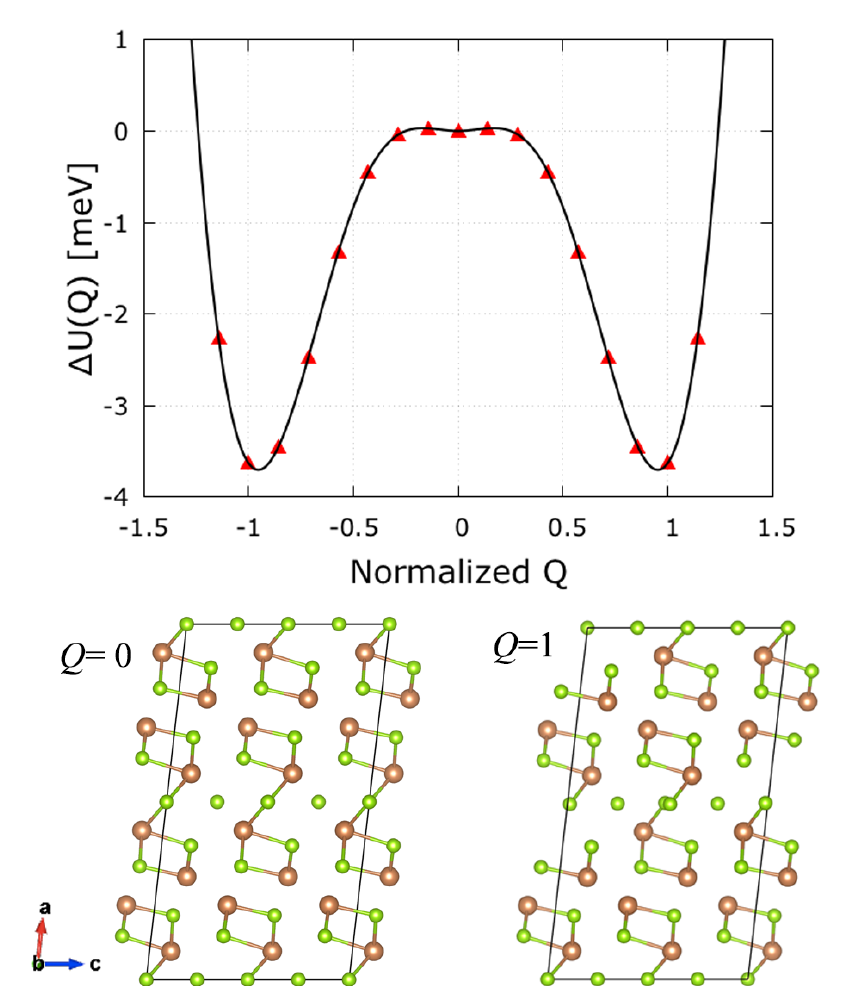
Figure A3. Double − well potential − energy surfaces for the phonon instabilities associated with the high-symmetry M − point negative modes (Figure 4). The normal-mode coordinates Q have been normalized so that the minima are located at Q = ± 1, and the energy differences are those calculated in a 1 × 2 × 2 supercell. The bottom figures represent the structure at Q = 0 ( left ) and at Q = 1 ( right